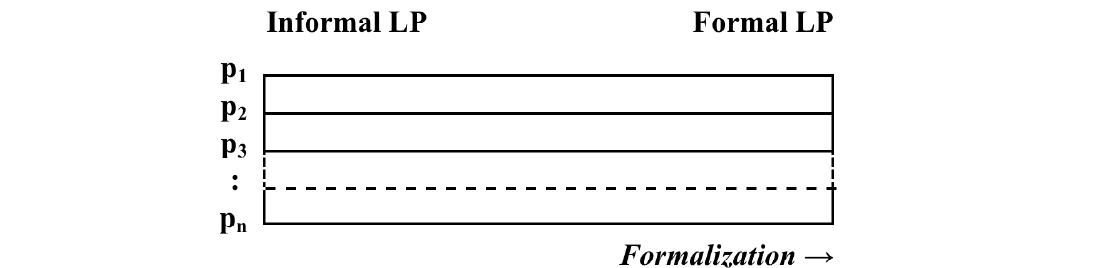
Source: Authors’ own